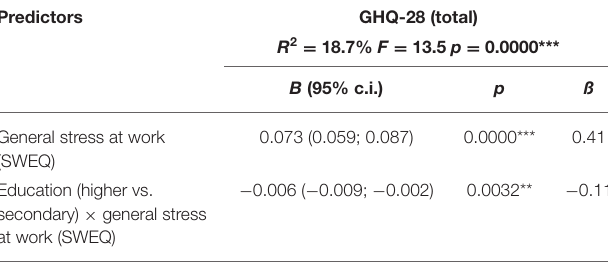
TABLE 6 | The effect of the overall measure of work-related stress and education levels on overall mental health.